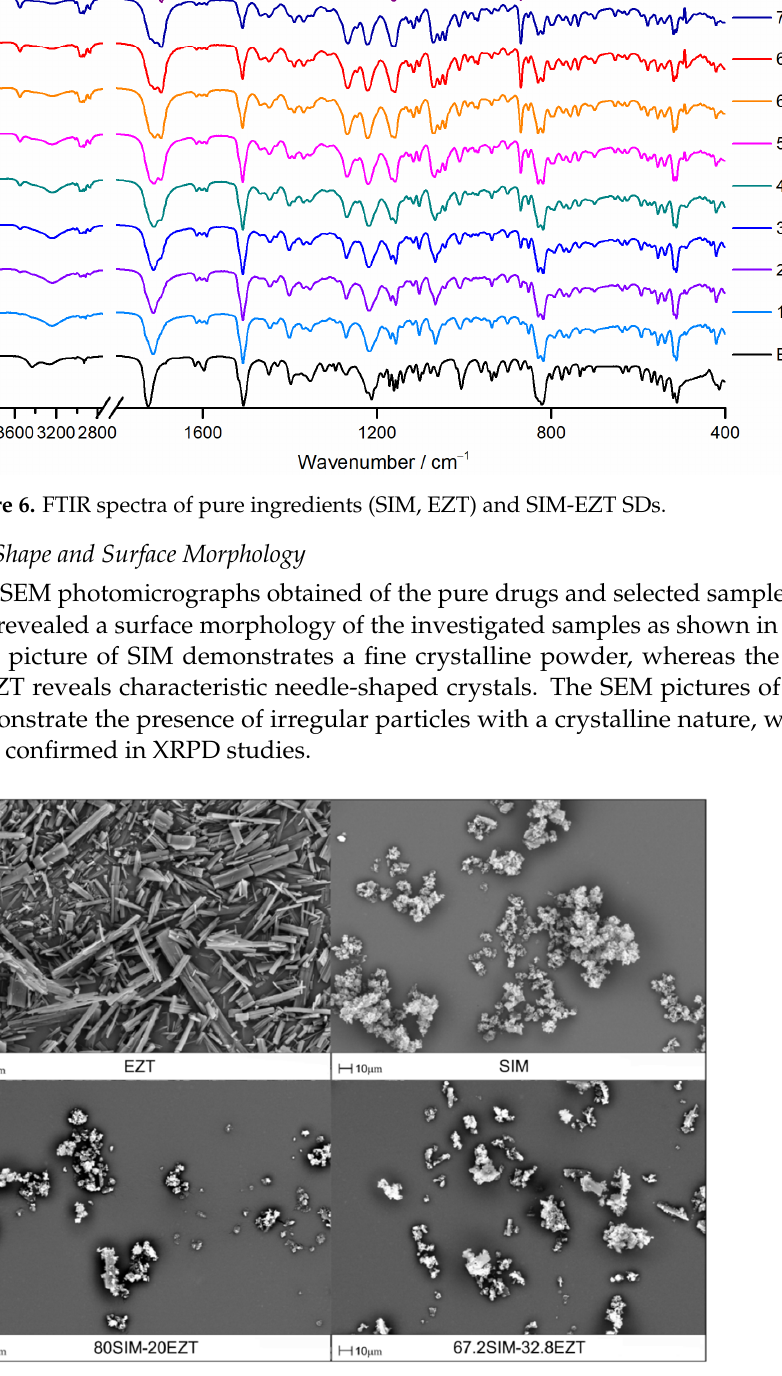
Figure 7. SEM photomicrographs of EZT, SIM, and selected SIM-EZT SDs.